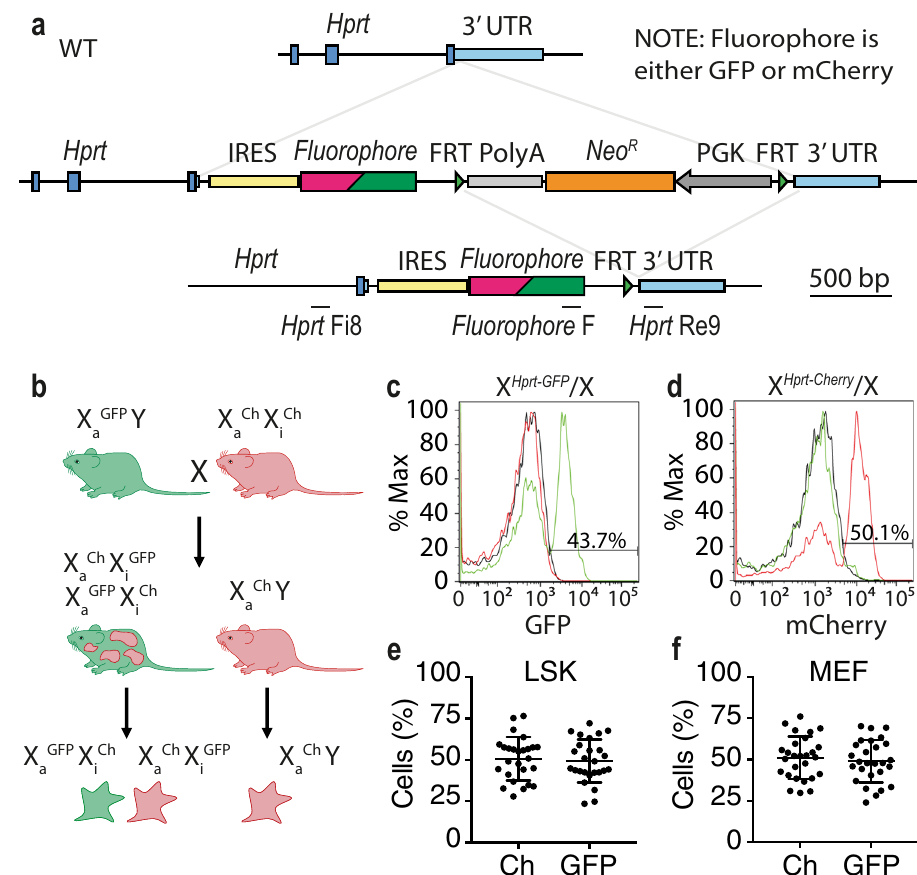
Fig. 1 Creation of Xmas reporter alleles and strains of mice. a Schematic of the Xmas reporter alleles indicating the knockin of the reporter into the 3 ′ untranslated region (UTR) of Hprt . Note that fl uorophore indicates either GFP or mCherry, with each element cloned similarly. The Flipase recognition target (FRT) and internal ribosome entry sites (IRES) are indicated, as are the genotyping oligonucleotides. b Schematic of homozygous/hemizygous reporter allele mouse strains and their XCI status. c , d Flow cytometry data showing detection of the GFP ( c ) and mCherry ( d ) fl uorescent reporters from white blood cells of X Hprt- GFP /X (green) and X Hprt -mCherry /X (red) female mice, compared to XY (black) male mice. e , f Flow cytometry data showing the percentage of each fl uorescent reporter allele from ex vivo haematopoietic stem and progenitor cells (LSK) n = 26 independent replicates ( e ) and primary MEFs n = 26 independent replicates. f Error bars show mean ±standard deviation. Source data are provided as a source data fi